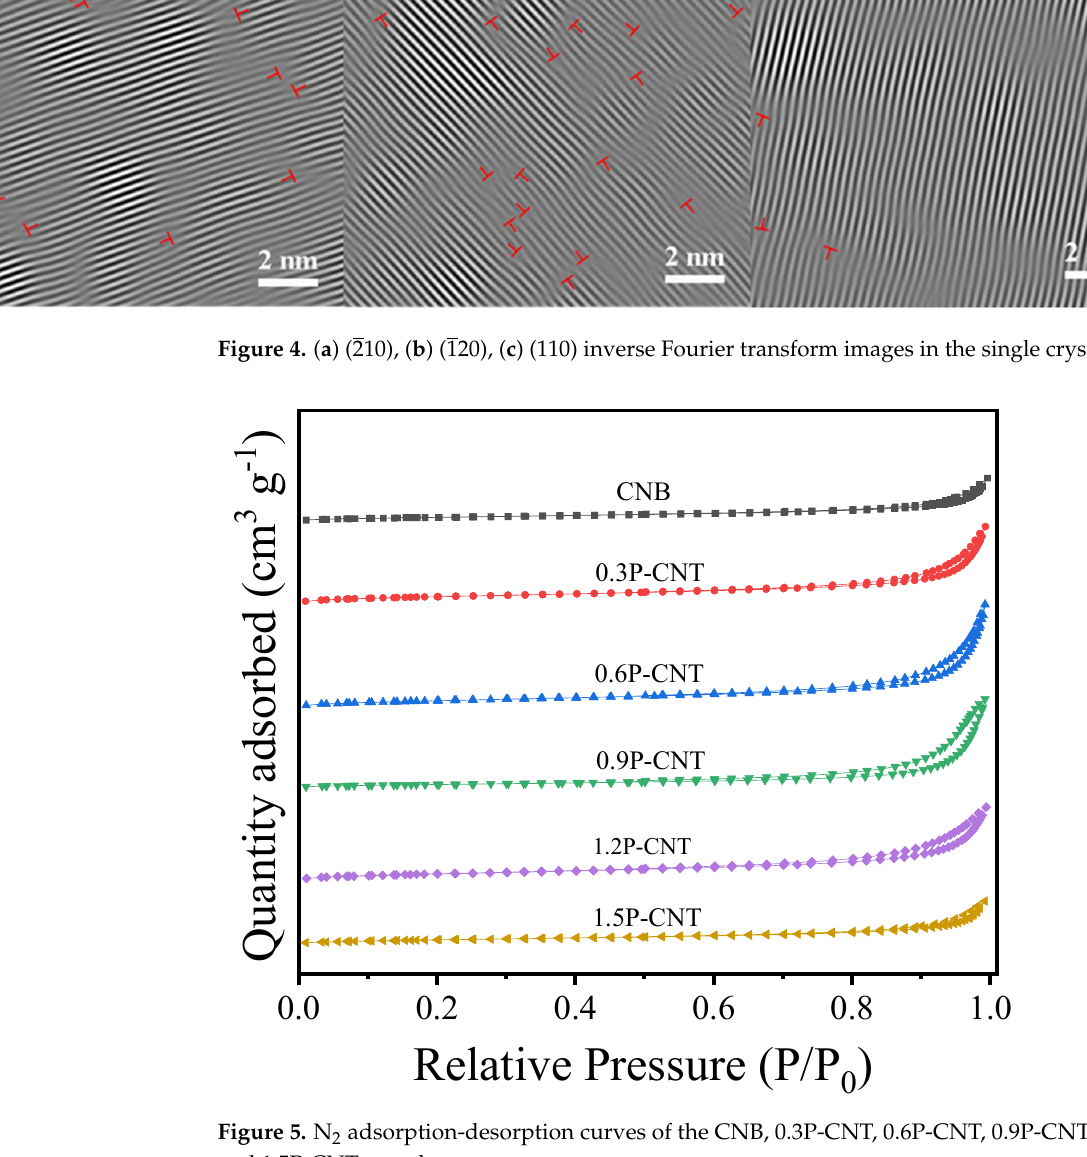
Figure 5. N 2 adsorption-desorption curves of the CNB, 0.3P-CNT, 0.6P-CNT, 0.9P-CNT, 1.2P-CNT, and 1.5P-CNT samples. Table 1. The SSA of the CNB, 0.3P-CNT, 0.6P-CNT, 0.9P-CNT, 1.2P-CNT, and 1.5P-CNT.